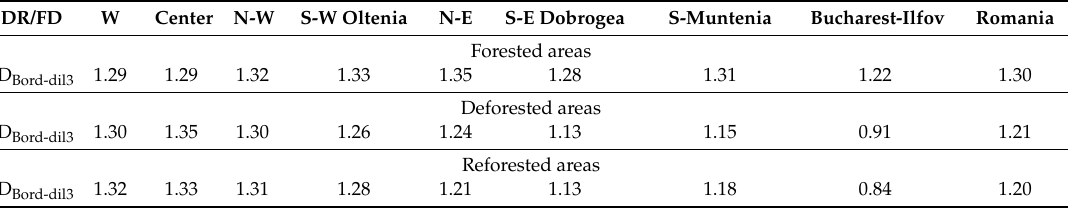
Table 6. Fractal dimension of forested, deforested and reforested areas (D Bord-dil3 ) from development regions of Romania